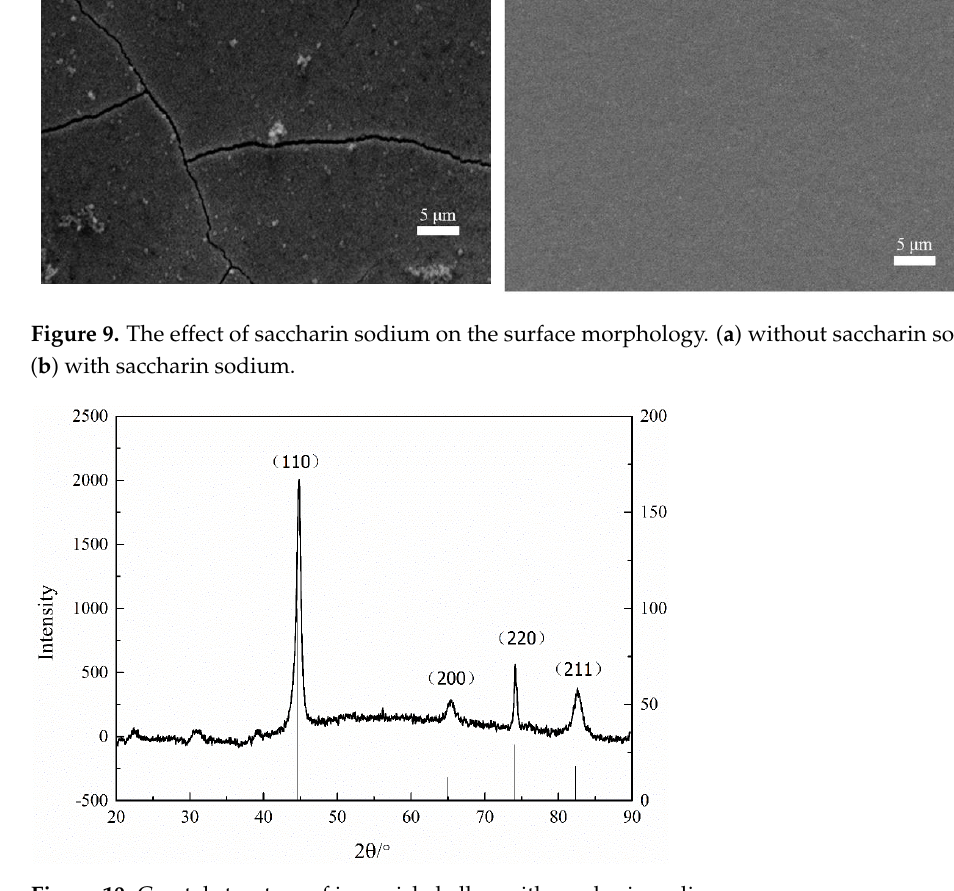
Figure 10. Crystal structure of iron-nickel alloy with saccharin